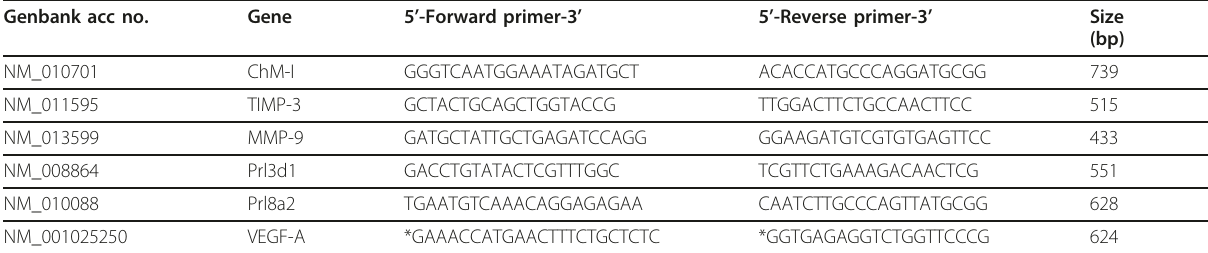
Table 2 Primers for cDNA fragment cloning Genbank acc